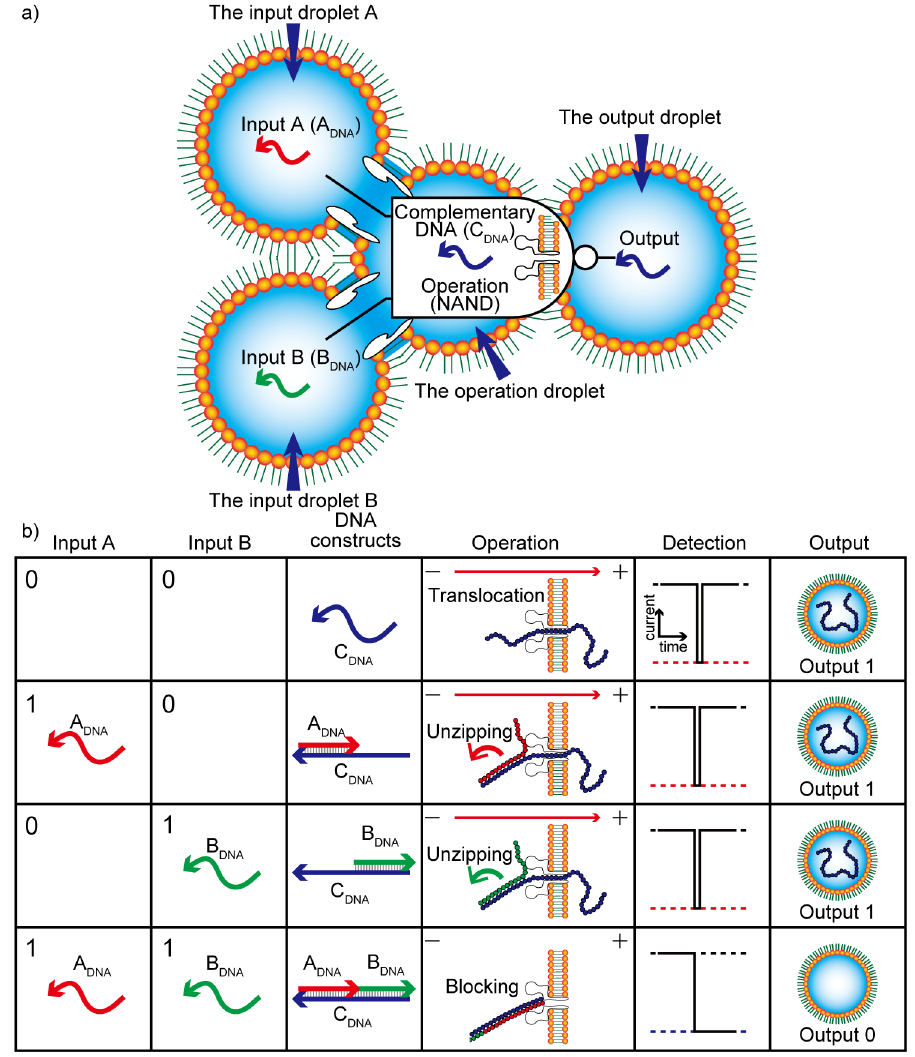
Fig 2. Negative-AND (NAND) operation system based on DNA translocation. (a) NAND logic gate concept based on α HL nanopores and three types of DNA strands, A DNA , B DNA , and complementary DNA (C DNA ) in a droplet network. (b) A schematic table of NAND operations with the DNA structures and nanopore result for each input.